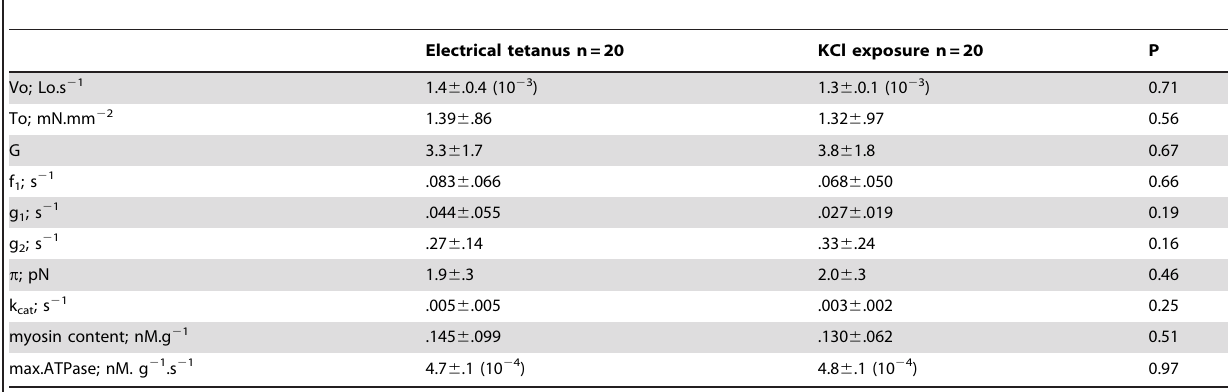
Table 1. Mechanical parameters of human placental stem villi (PSV) and molecular myosin characteristics under electrical tetanus and KCl